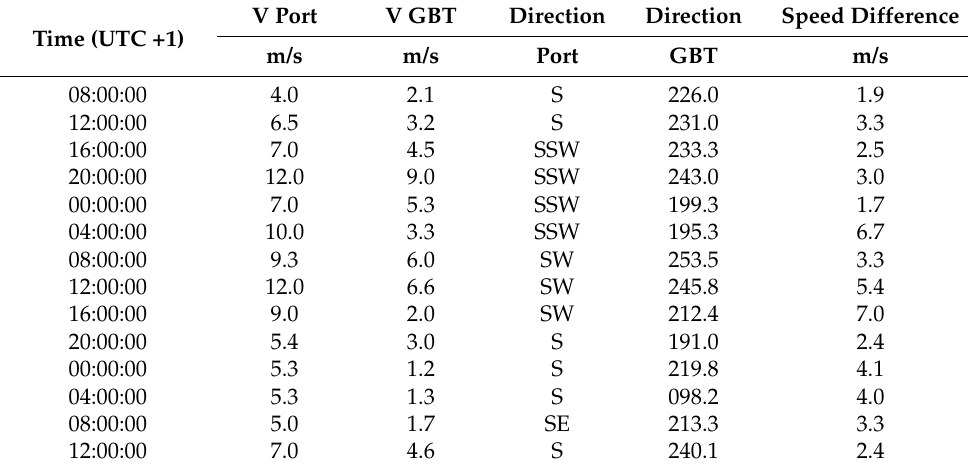
Table 2. Recorded wind directions and speeds.